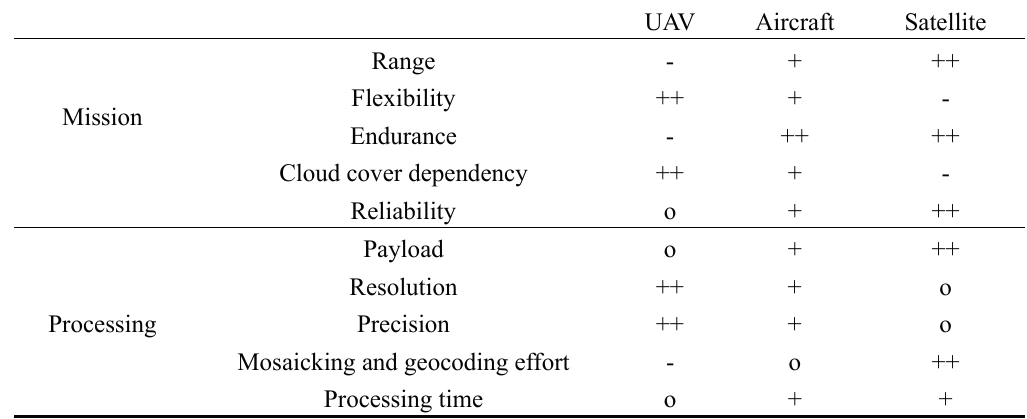
Table 5. Comparative platform characteristics for different remote sensing platforms. (++ optimal, + good, o average, -